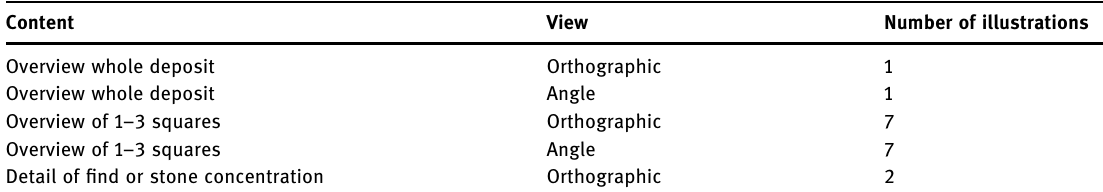
Table 1: The di ff erent uses of IVS illustrations in the student reports of 2019 Content